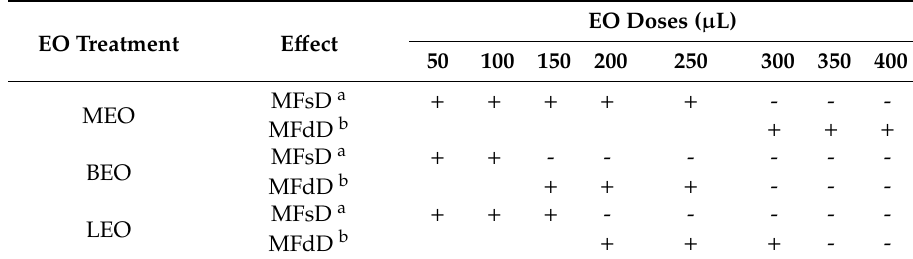
in vitro Table 2. Values of fungistatic and fungicidal doses of essential oils used as the vapor-phases in the in vitro study.